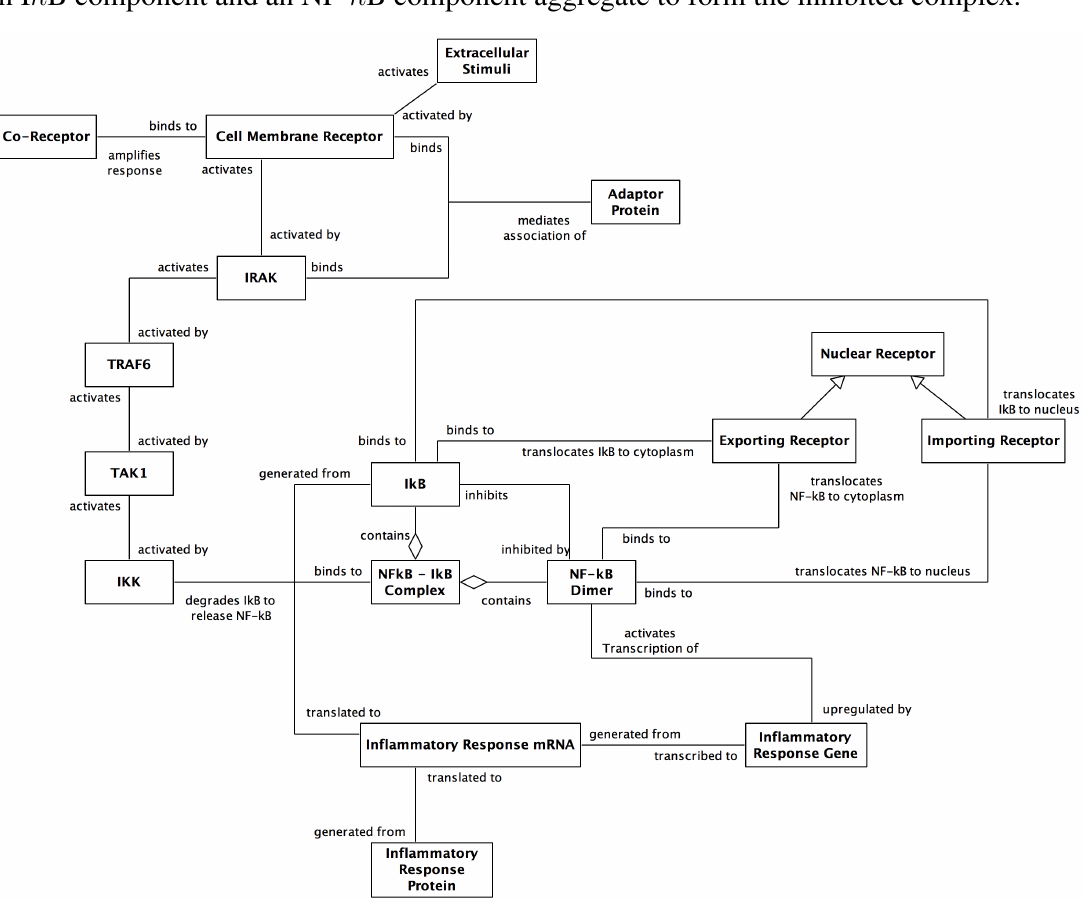
Figure 3. Unified Modelling Language (UML) class association diagram for the canonical NF- κ B signalling pathway. The layout used follows the spatial aspects of the cascade of component relationships involved in the biological system from cell membrane activation down to gene transcription within the nucleus. The diagram conveys directed relationships by the labels at each end of the connectors. The arrowheads pointing towards